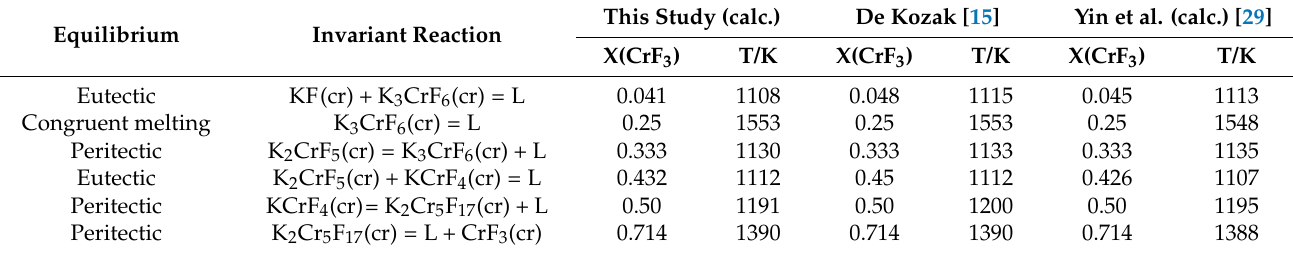
Table 7. Invariant equilibria in the KF–CrF 3